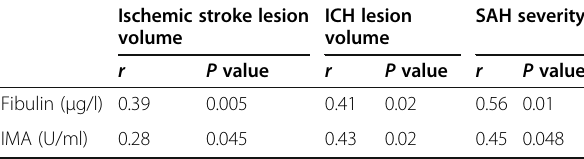
Table 6 Risk factors for IMA in stroke patients Clinical characteristics IMA levels (U/ml) in stroke patients